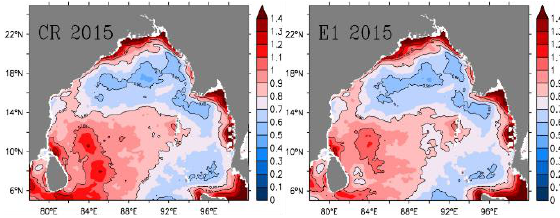
Figure 4. RMSE map of SST for CR and E1 with GHRSST for the year 2015